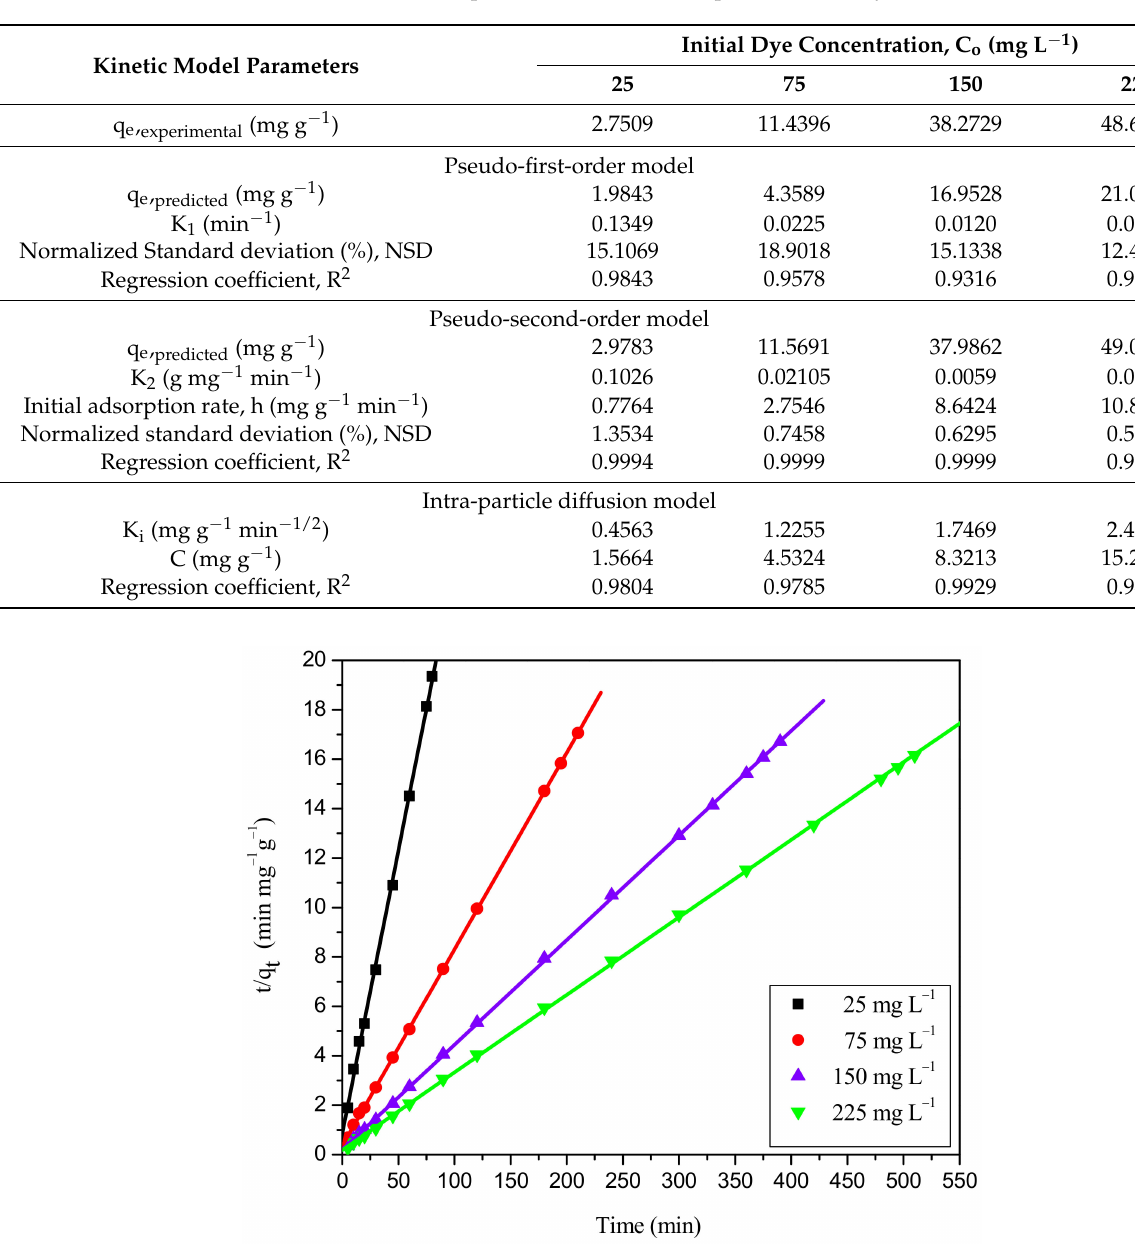
Figure 11. Ho’s pseudo-second-order kinetic plot for adsorption of RBBR dye onto WSBAC